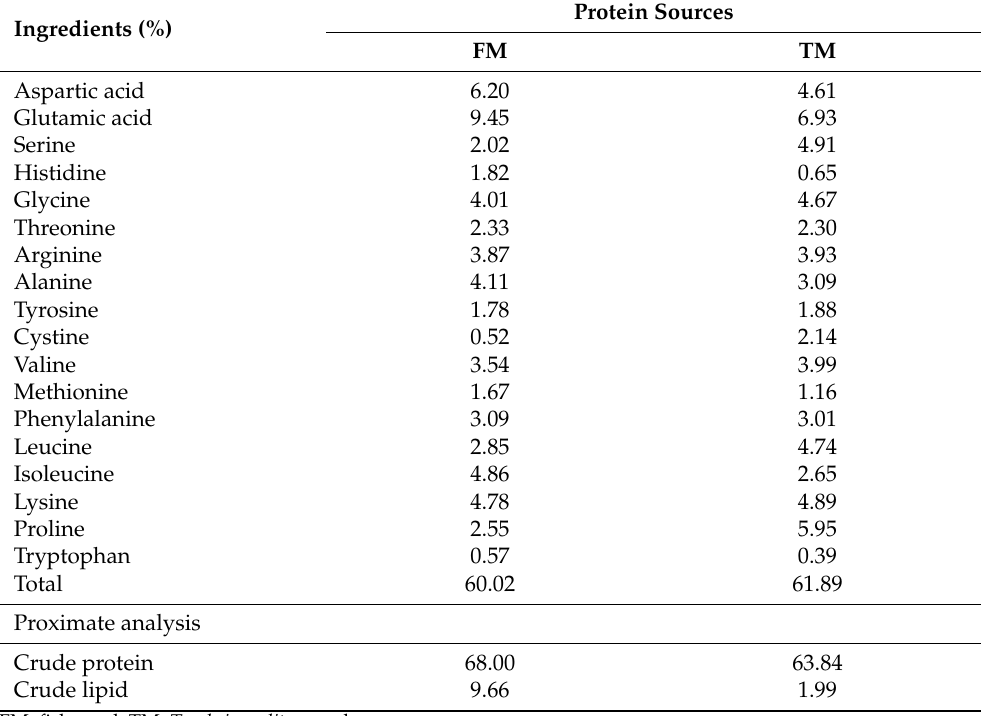
Table 1. Nutrient composition of FM and TM used in this study (% dry